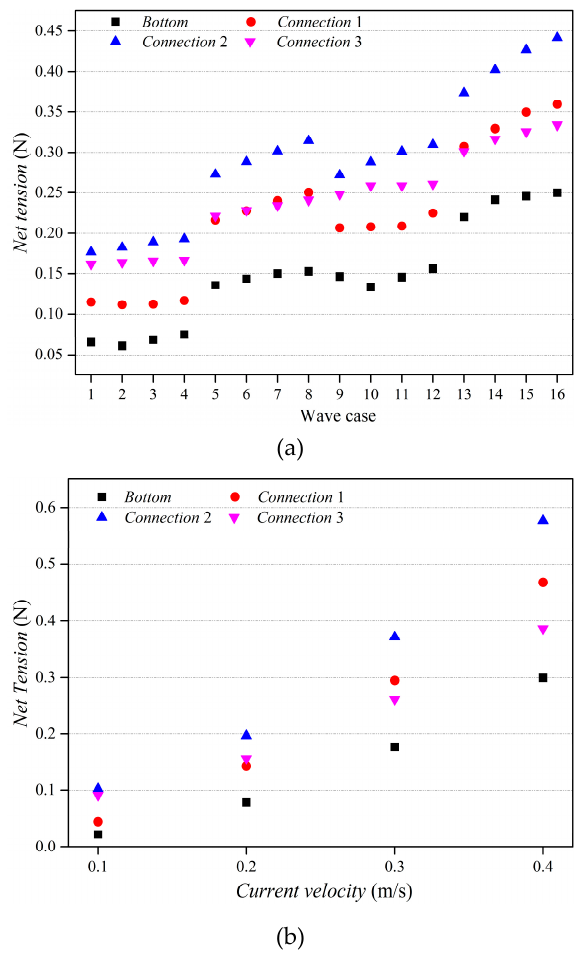
Figure 13. Maximum mooring line tension for floating rope enclosure induced by various wave-current conditions: ( a ) net tension under combined waves and currents, ( b ) net tension under currents